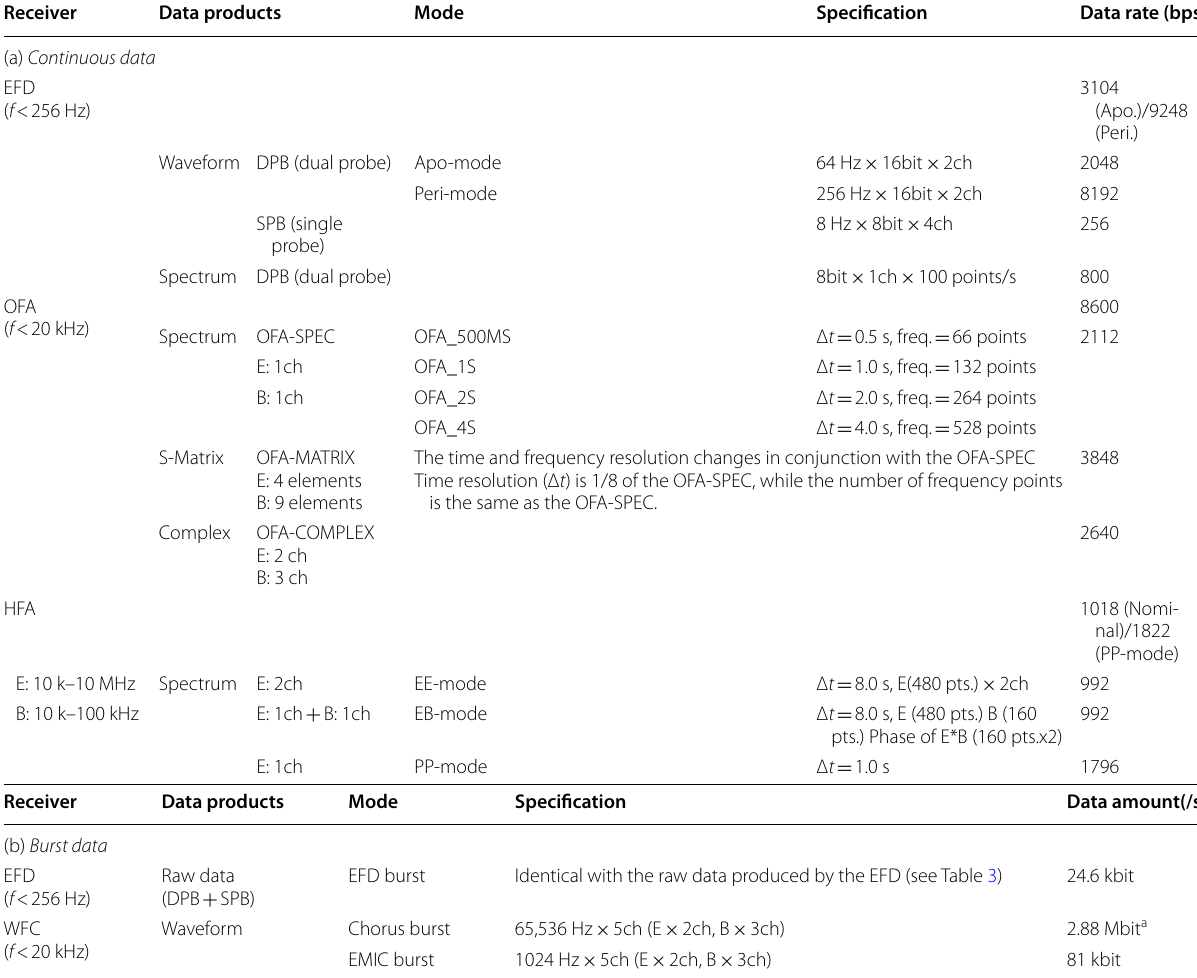
a Data amount in chorus burst mode is compressed to ~ 55% from the original